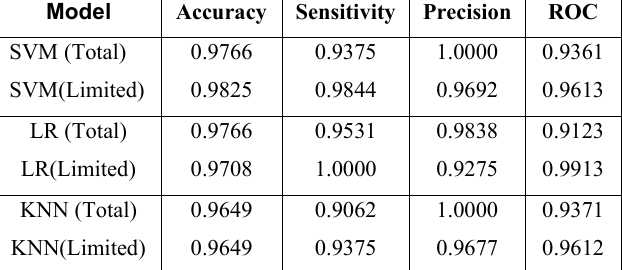
Table 3. Model outcomes (Total vs limited features) Model